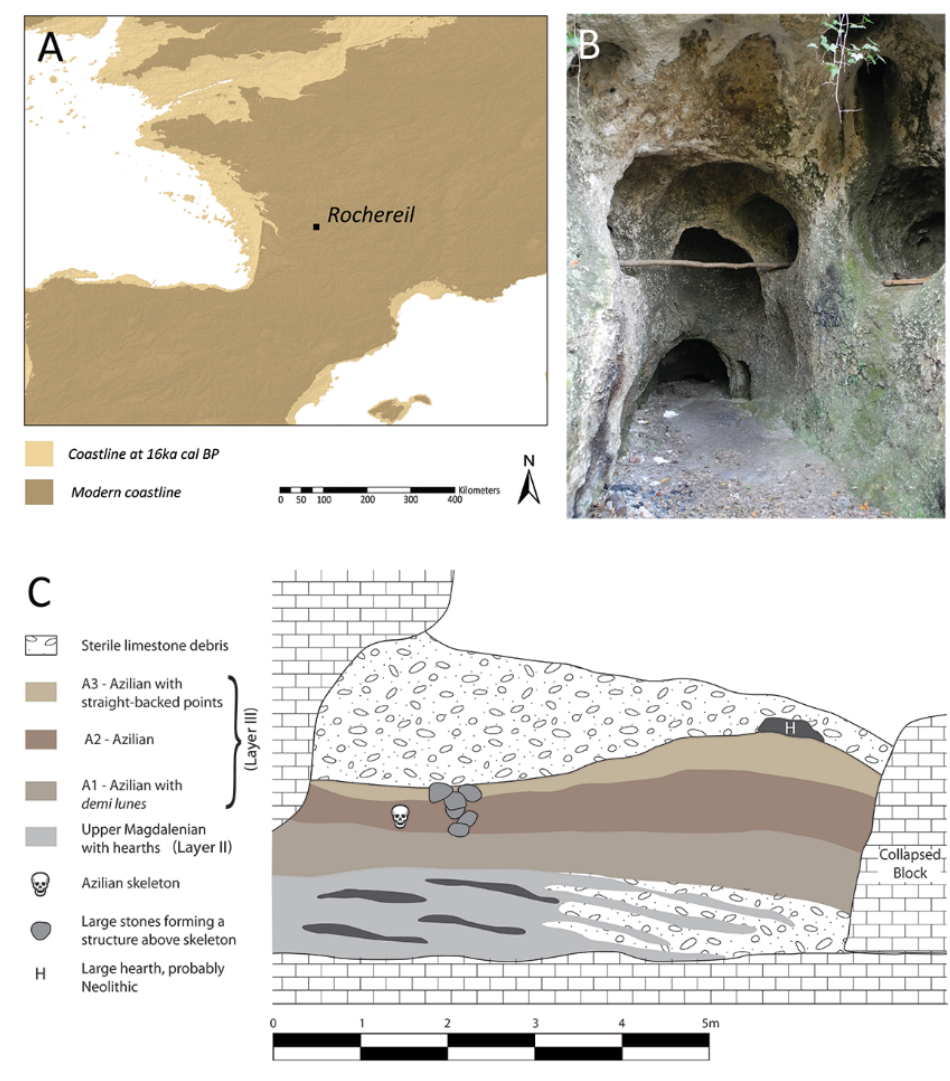
Figure 1: Location of the site of Rochereil (A); photograph of the cave entrance of Rochereil (B); stratigraphy of Rochereil redraw from Jude and Cruveiller 1938